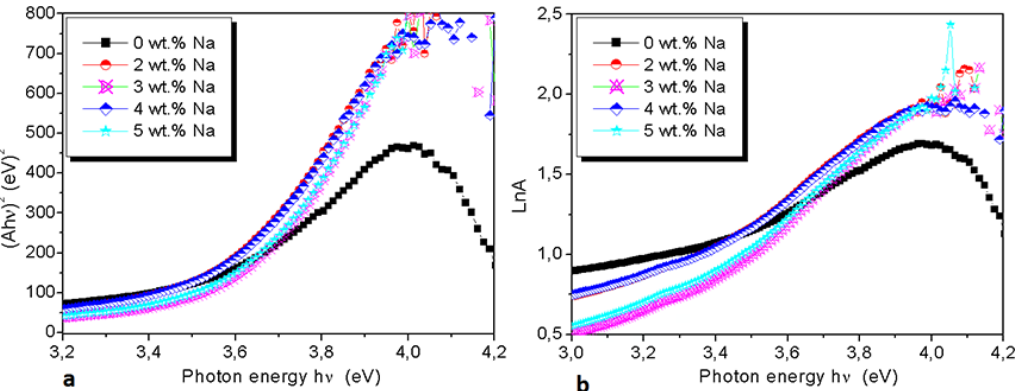
Figure 5. a. The typical variation of ( Ahv ) 2 vs. photon energy hv for Na doped NiO thin films; b. The drawn of ln A as a function of photon energy ( hv ) for deduce the Urbach energy for Na doped NiO thin films.